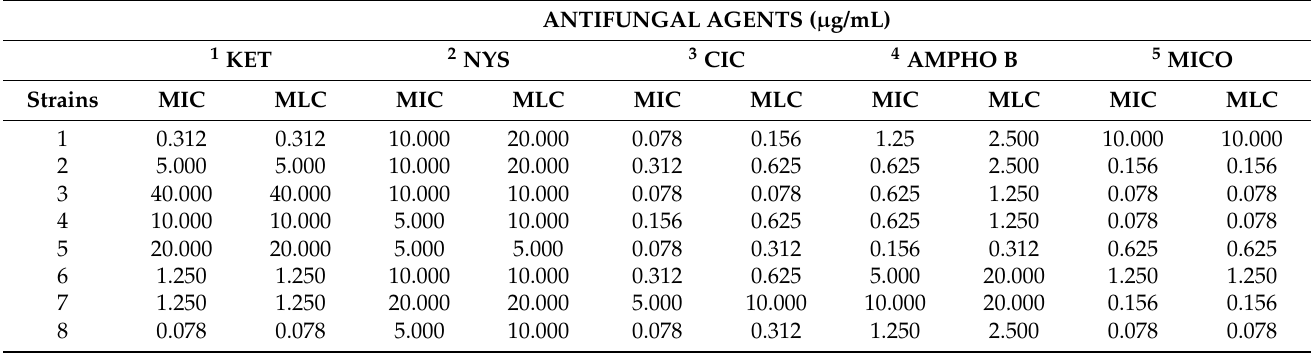
Table 3. MIC and MLC of the antifungals for reference strains of Candida , determined by microdilution techniques in culture broth and viable cell counts,